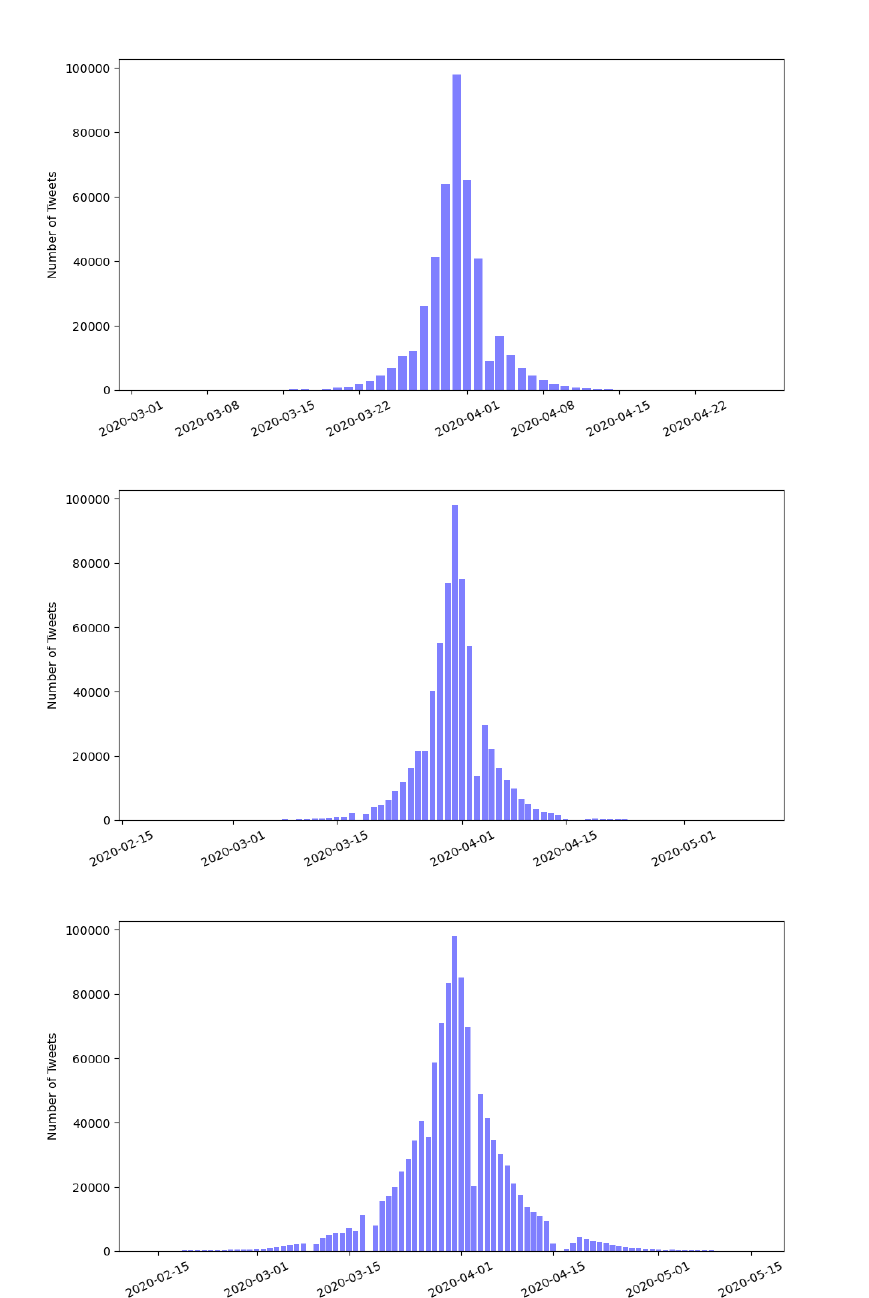
Figure H.2. Contributions of tweet volume from various time points for tempo- rally smoothed corpora. The examples are constructed for March 31 , using smoothing parameters 0 . 65 , 0 . 75 , 0 . 85 (from top to bottom). Although the plots exhibit different resolu- tions and spans of the histograms, the shapes of the contribution distributions are similar in all cases. This illustrates robustness of the proposed method to the choice of smoothing